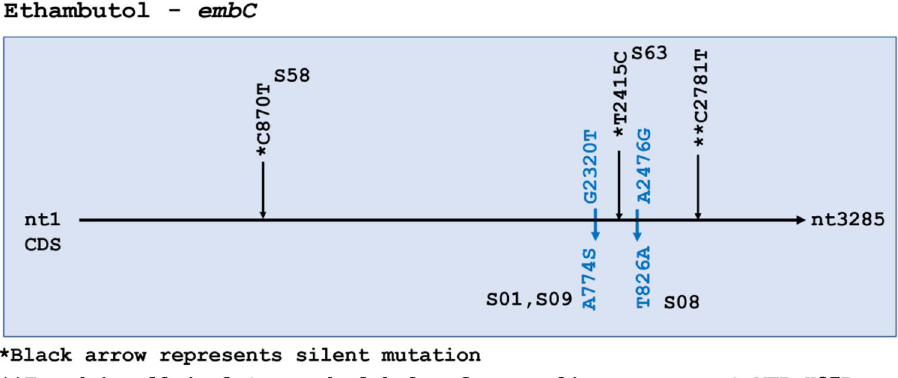
Figure 4. Ethambutol resistance-associated gene embC had 2 missense single nucleotide polymorphisms (SNPs) and one silent SNP (**C27181T) found in all 66 isolates in the data set as well all reference strains except H37Rv and is not considered particularly informative. All samples were wildtype for embA. Missense mutations are colored blue. Silent mutations are represented in *black color.